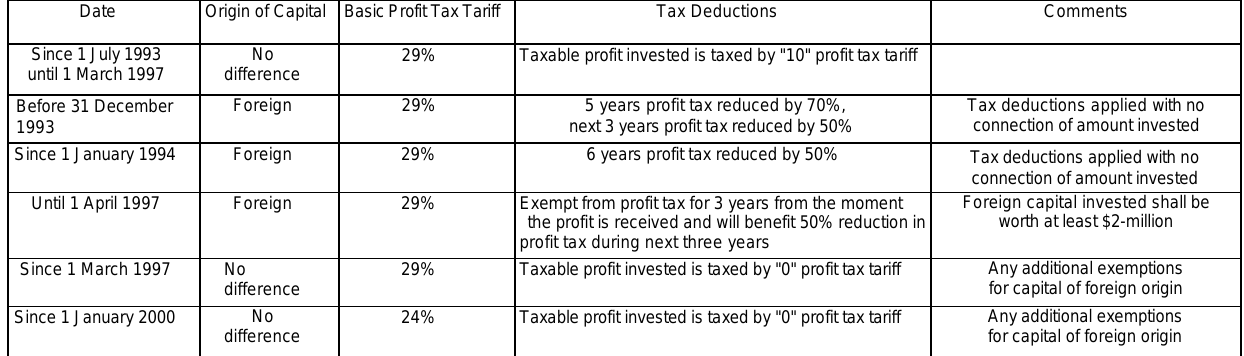
Table 1. Legal Environment of Operating Business Firm Stipulating Stimuli for